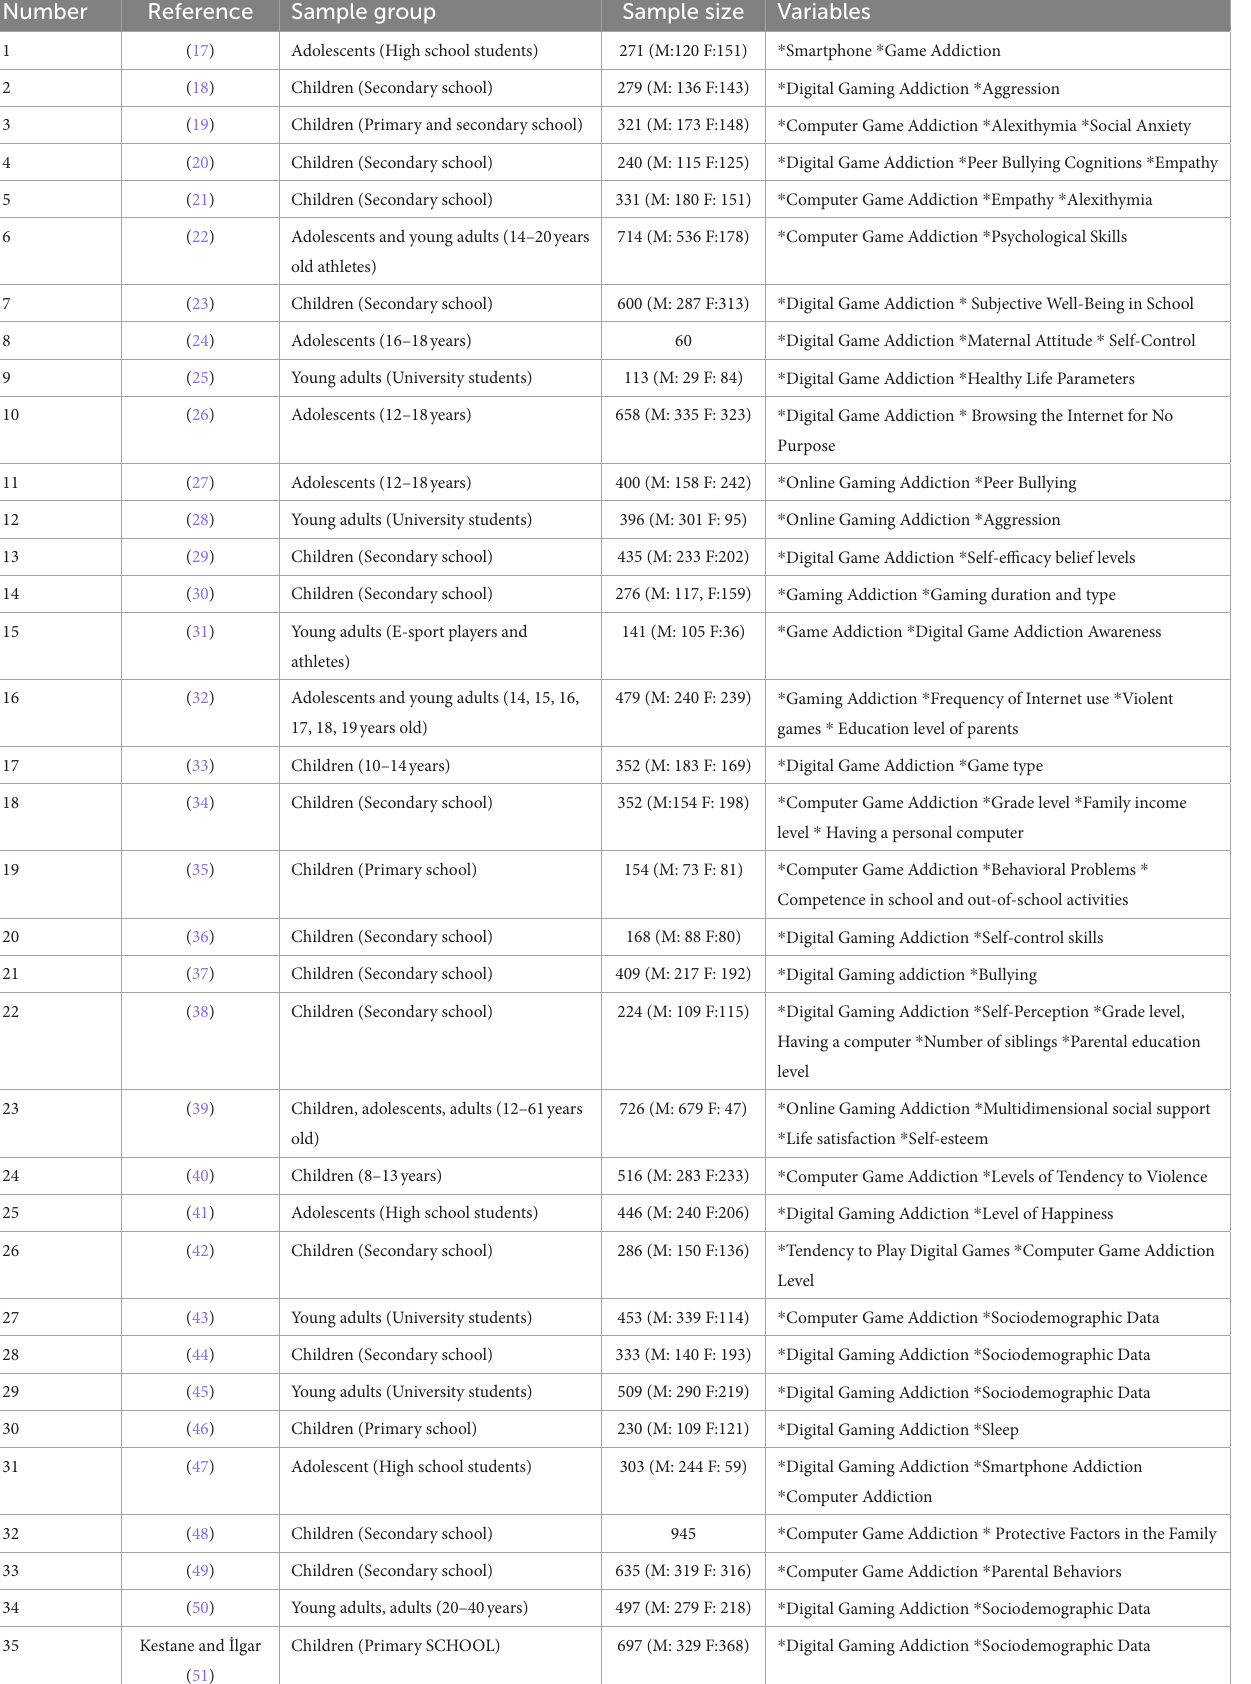
TABLE 1 Methodological trends in digital game addiction